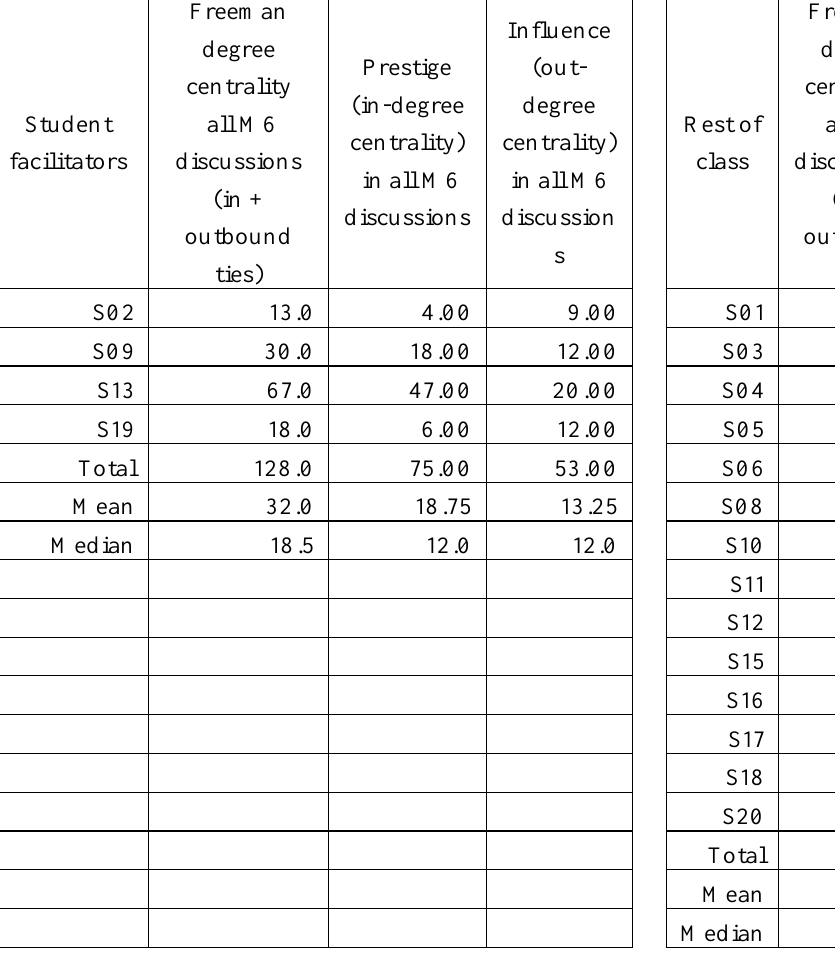
Table 2 Comparison of Centrality, Prestige, and Influence for Student Facilitators and Non-